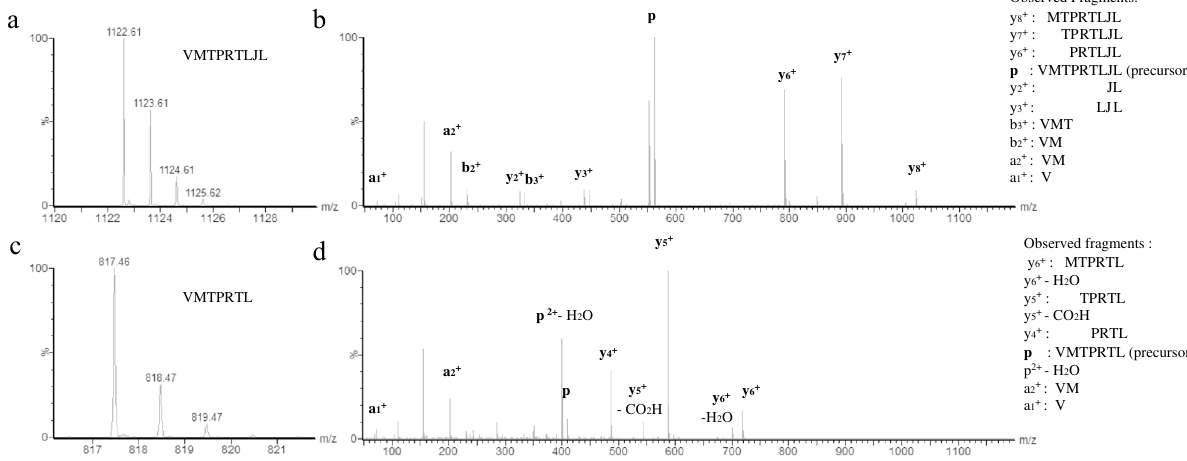
Figure 2. Characterization of pUV G2 peptide cleavage by mass spectrometry. Peptides were diluted to a concentration of 64.8 µM and injected onto a C18 column. Mass spectrometry profiles are shown for native pUV G2 peptide ( a , b ) and the cleaved G2 peptide ( c , d ). ( a , c ) represent the LC profiles with the peptide sequence. ( b , d ) show the MS/MS profiles with the identified fragments allowing sequence deduction.